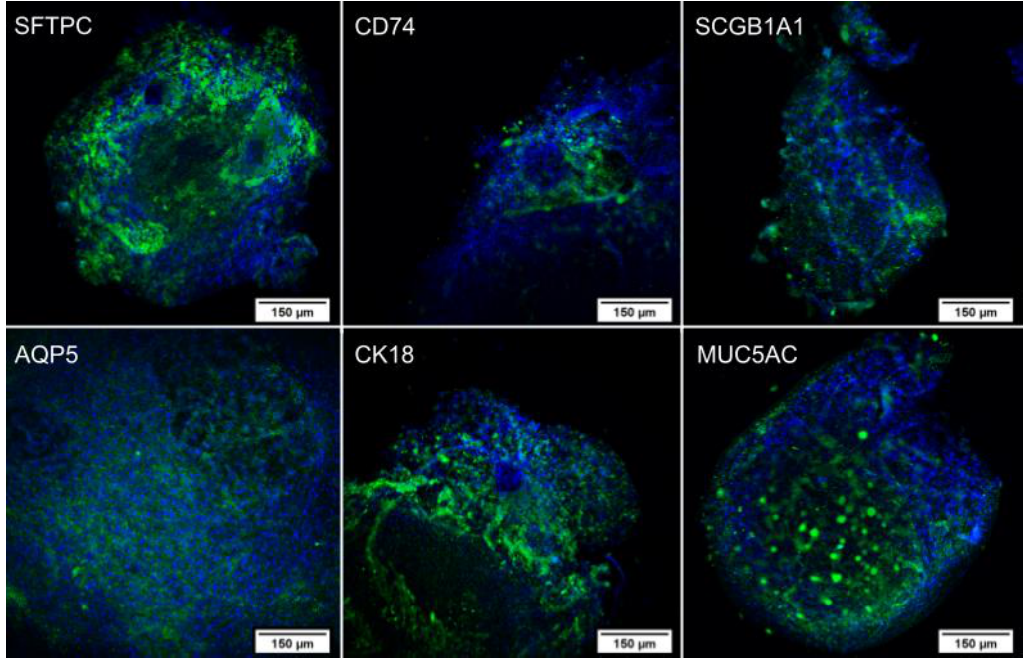
Figure 3. Immunocytochemistry of lung organoids (sample C10) with DAPI marking the nuclei in blue and FITC labeling the specific proteins in green. Images obtained using a high-throughput microscope In Cell Analyzer 2000 (GE Healthcare ® , Chicago, IL, USA).